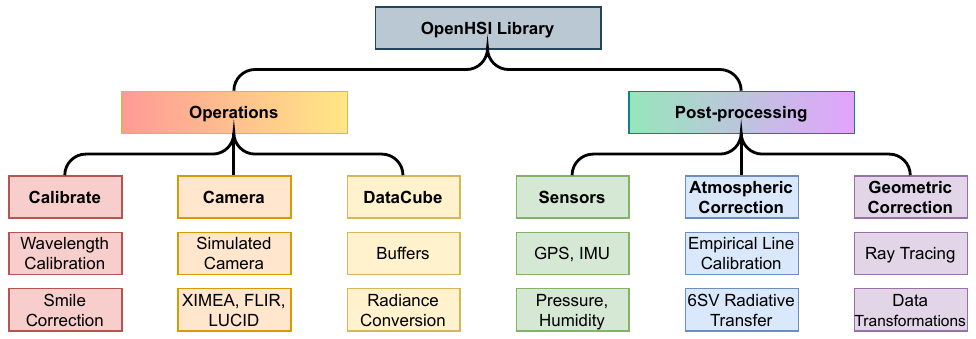
Figure 8. Current OpenHSI library